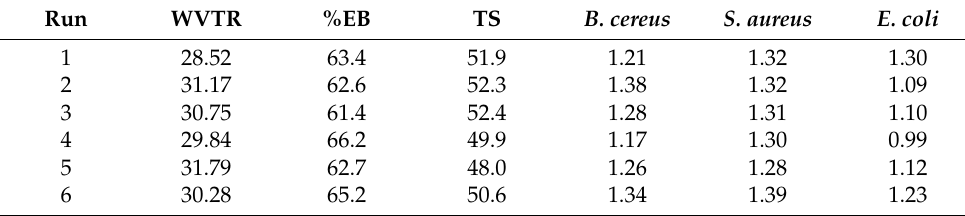
Table 5. Response data of confirmation formula: ZnO-NPs 1% without adding